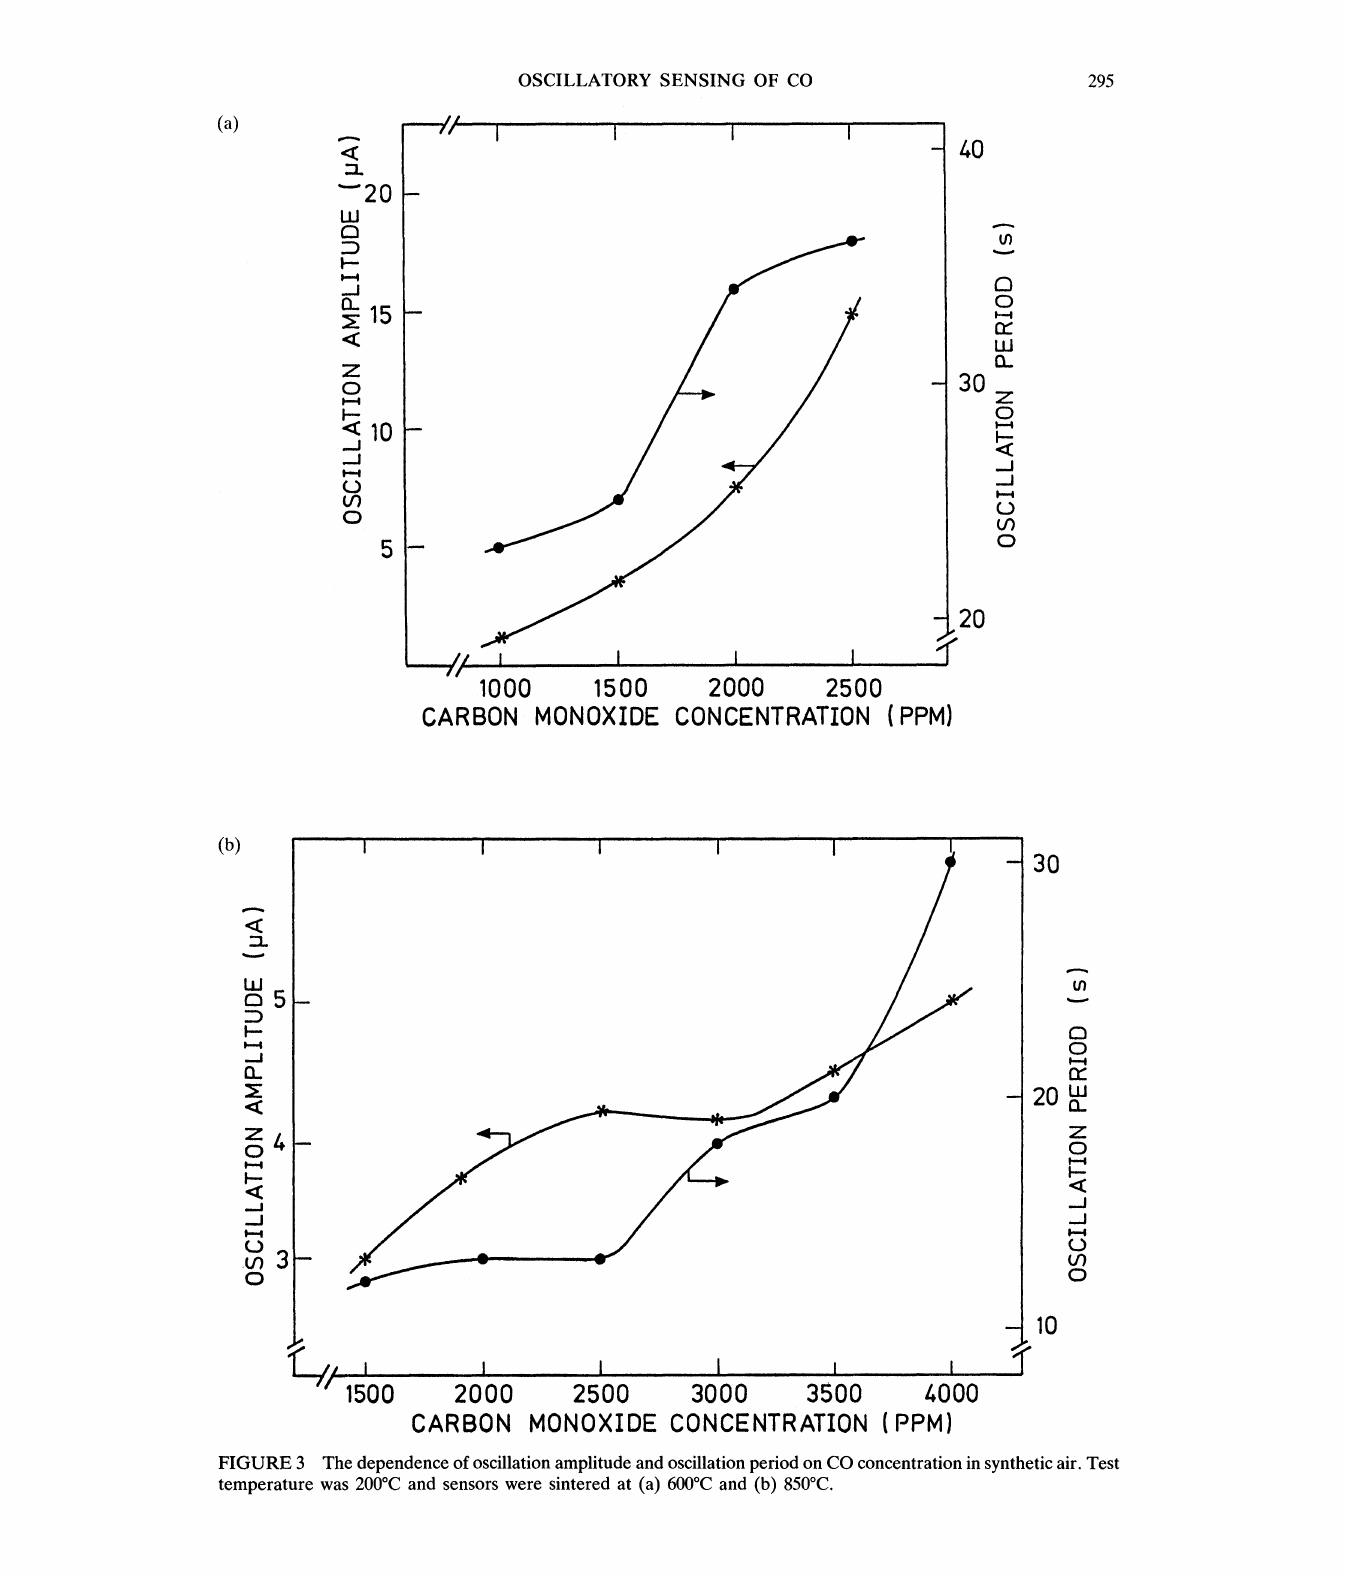
FIGURE 3 The dependence of oscillation amplitude and oscillation period on CO concentration in synthetic air. Test temperature was 200C and sensors were sintered at (a) 600C and (b)